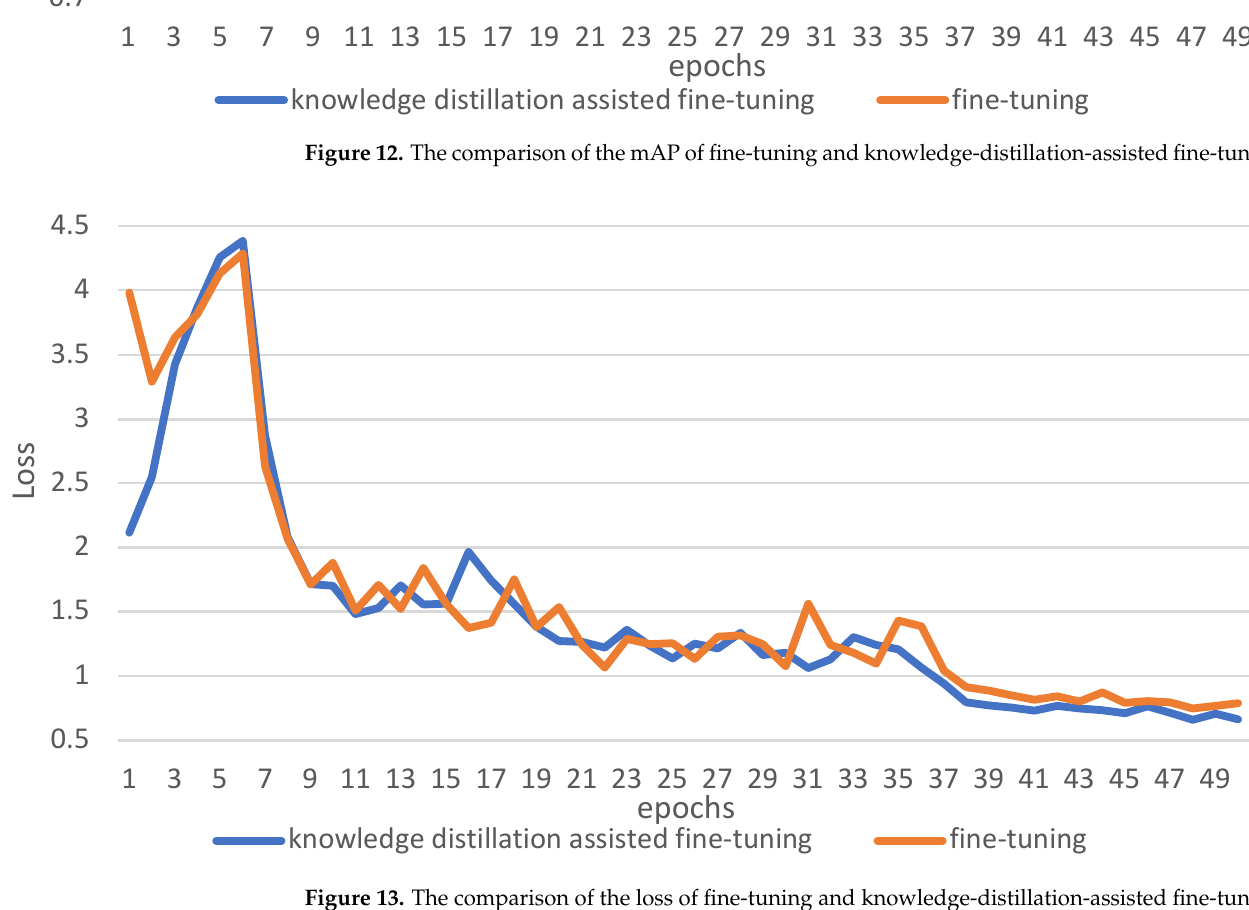
Figure 13. The comparison of the loss of fine-tuning and knowledge-distillation-assisted fine-tun- ing.